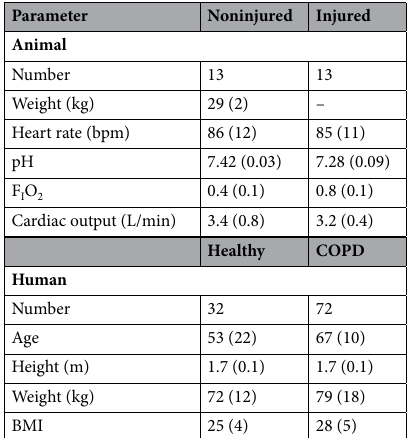
Table 2. Characteristic summary of the animal and human data measured by the IST. Mean (SD) are shown. F I O 2 is the fraction of inspired